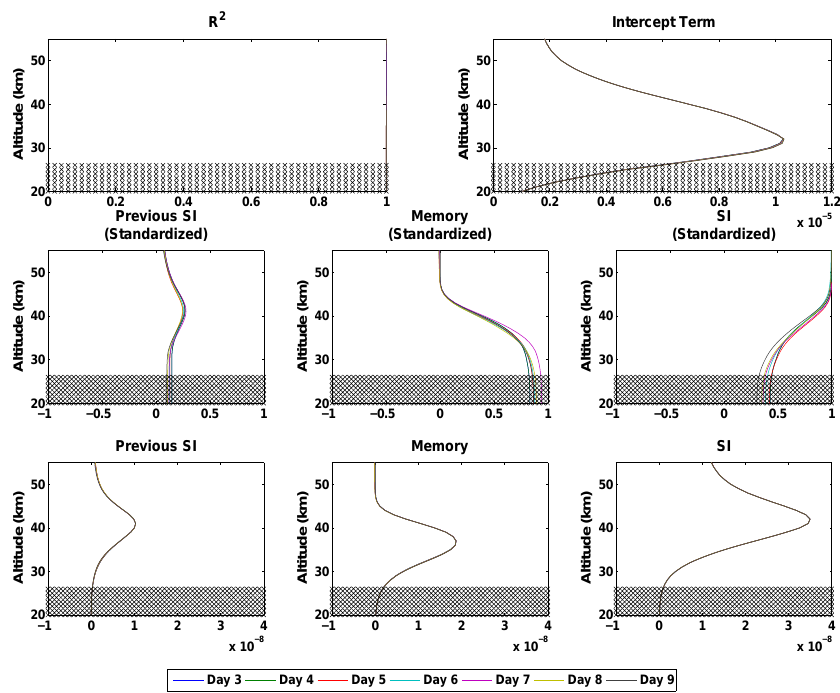
Fig. 5. Regression coefficients for the 3-predictor autoregressive model for simulation days 3 to 9 (different colours). Top row: adjusted coefficient of determination ¯ R 2 (left) and intercept term α 0 = ¯ y (right). Middle row: standardised previous day’s solar irradiance term δ (left), standardised memory term β (middle) and standardised solar irradiance term γ (right). Lower row: non-normalised previous day’s solar irradiance term δ 0 (left), memory term β 0 (middle) and solar irradiance term γ 0 (right). Regions where the standard deviation (amongst the ensemble) in the observed variable y was smaller than 5% of the maximum standard deviation in the column are hatched out.